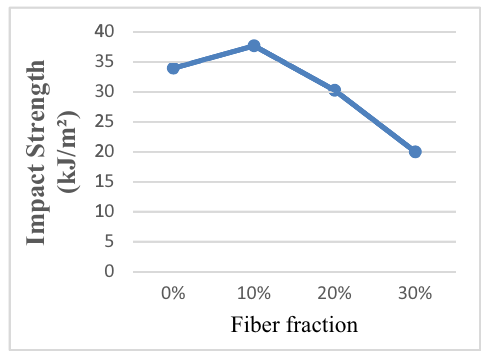
Figure 4: Impact strength of r - HDPE/bamboo composite.